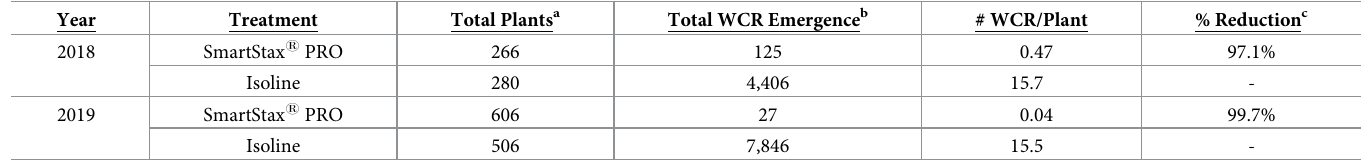
a Total plants sampled from three tents in 2018 and eight tents in 2019. Each plot had one emergence tent in 2018 and two emergence tents in 2019. b Total number of western corn rootworm adults collected from all emergence tents per treatment. c Percent reduction in adult emergence compared to isoline due to SmartStax 1 PRO larval